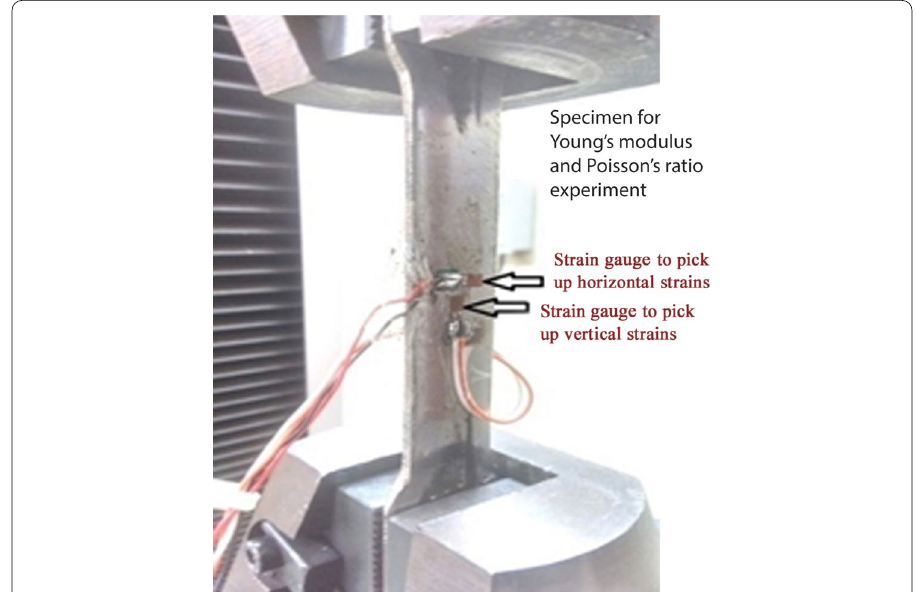
Fig. 8 Specimen with strain gauges loaded in the UTM for Poisson’s Ratio Experiment